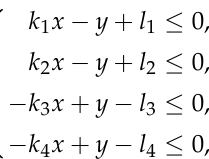
Fig. 2. MacAdam ellipses in CIE 1931 color space chromaticity diagram with 10 times the actual size in MacAdam’ experiment.